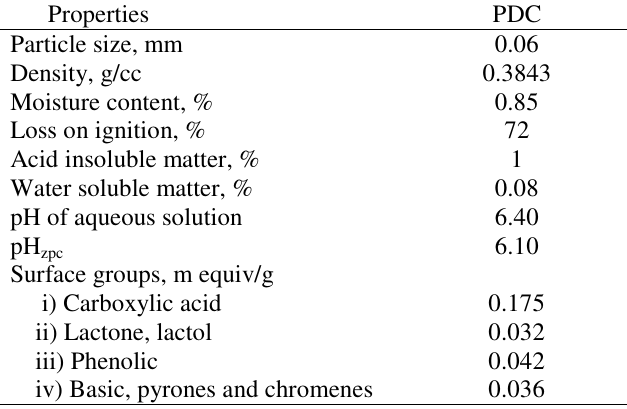
Table 1. Characteristics of the adsorbent